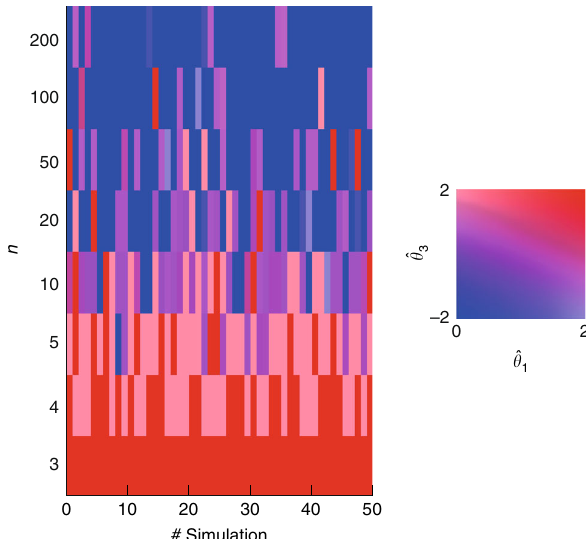
Fig. 9 Results of the Preferential Attachment test. For each of the 50 simulations, we study the behavior of the newborn agent n . The left plot shows the minimizer of the distance function through the color map on the right, which associates a color to each pair ð ^ θ 1 ; ^ θ 3 Þ . For illustration and computational purposes, we restrict the parameter space to ~ Θ ¼ ½ 0 ; 2 (cid:4) ´ 0 ´ ½(cid:3) 2 ; 2 (cid:4) , and the action space of the newborn agent n to ~ A ¼ f a n 2 f 0 ; 1 g n (cid:3) 1 ; s : t : jj a n jj 1 (cid:5) m out g . In other words, the newborn agent n can only choose among all the combinations of (at maximum) m out outgoing edges (of weight 1). Hence, we solve ð ^ θ n ; 1 ; ^ θ n ; 3 Þ 2 R 1 = 2 ; and we select the estimate with argmin θ ~ Θ ð ~ A e þ n ð a n ; θ n Þ 2 d a n Þ n 2 maximum Euclidean norm among the